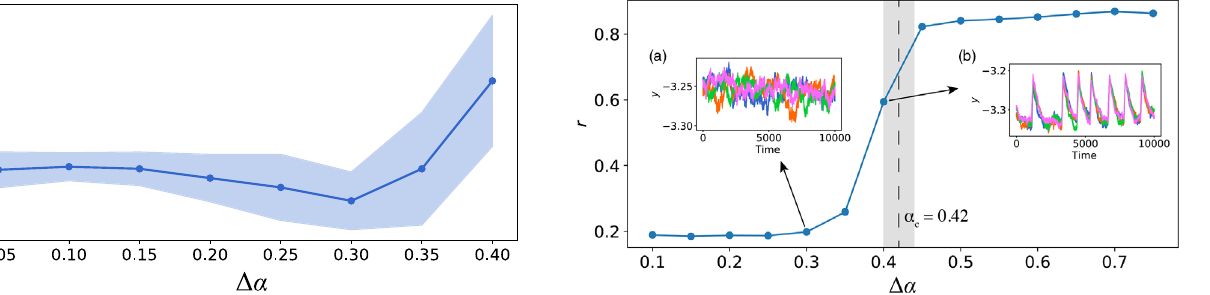
FIG. 4. Prediction of critical transitions in the rich club of the cat cerebral cortex. The level of synchronization r of the rich club is shown for different values of the coupling strength. Insets show time series of neuronal dynamics of four rich-club members, and color of time series matches with the color of nodes in Fig. 1. For values in the gray shaded region, r is increasing toward close to one and the rich club exhibits collective behavior. We can predict the critical coupling α (standard deviation in shaded region) by c studying the effective network obtained from a time series measured at Δ α ¼ 0 . 3